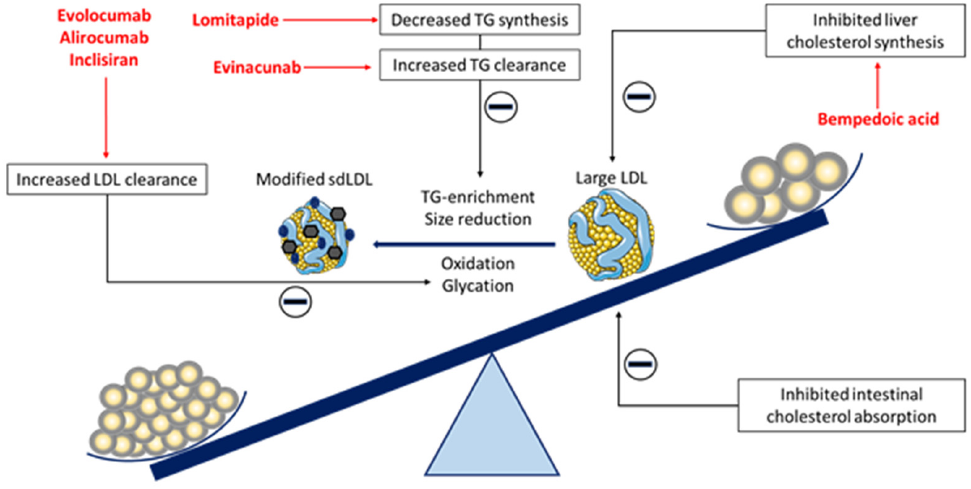
Figure 1. Therapeutic approaches for the reduction in sdLDL particles.